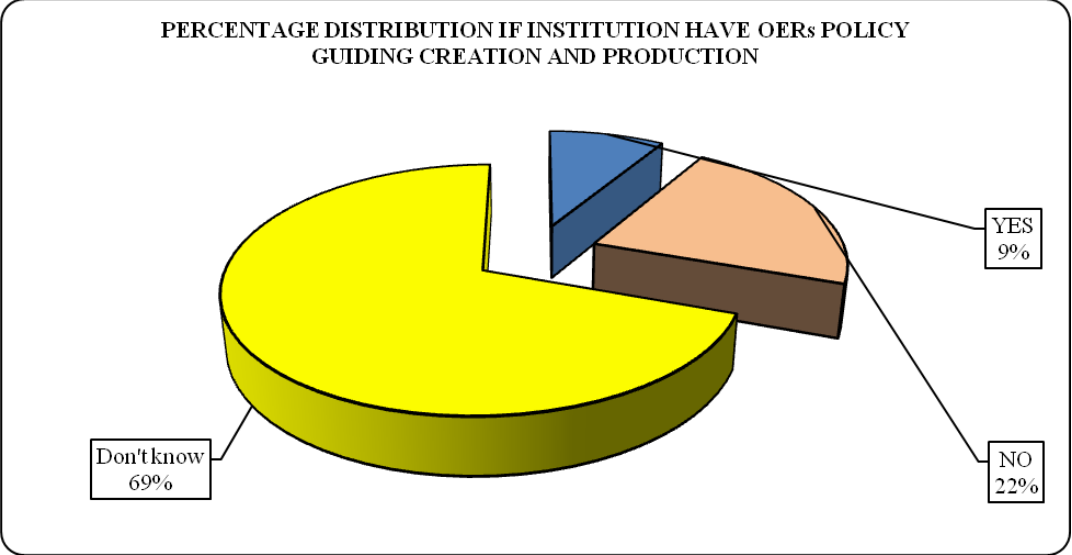
Figure 7. Awareness of whether the University has an OER